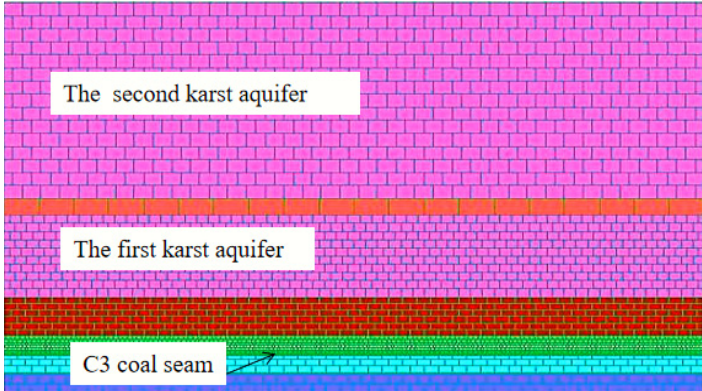
Figure 2. UDEC numerical model.